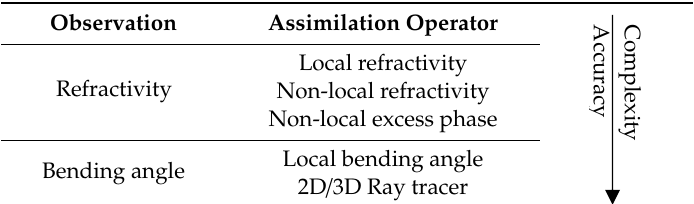
Table 2. RO operator in data assimilation.